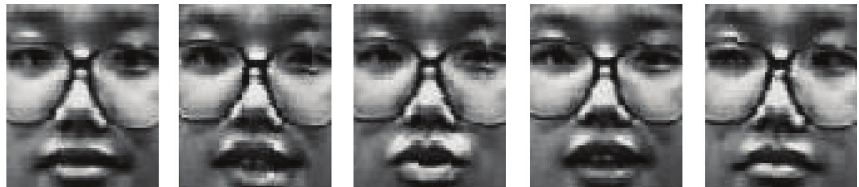
Figure 2: Five face image samples from the Essex94 database.